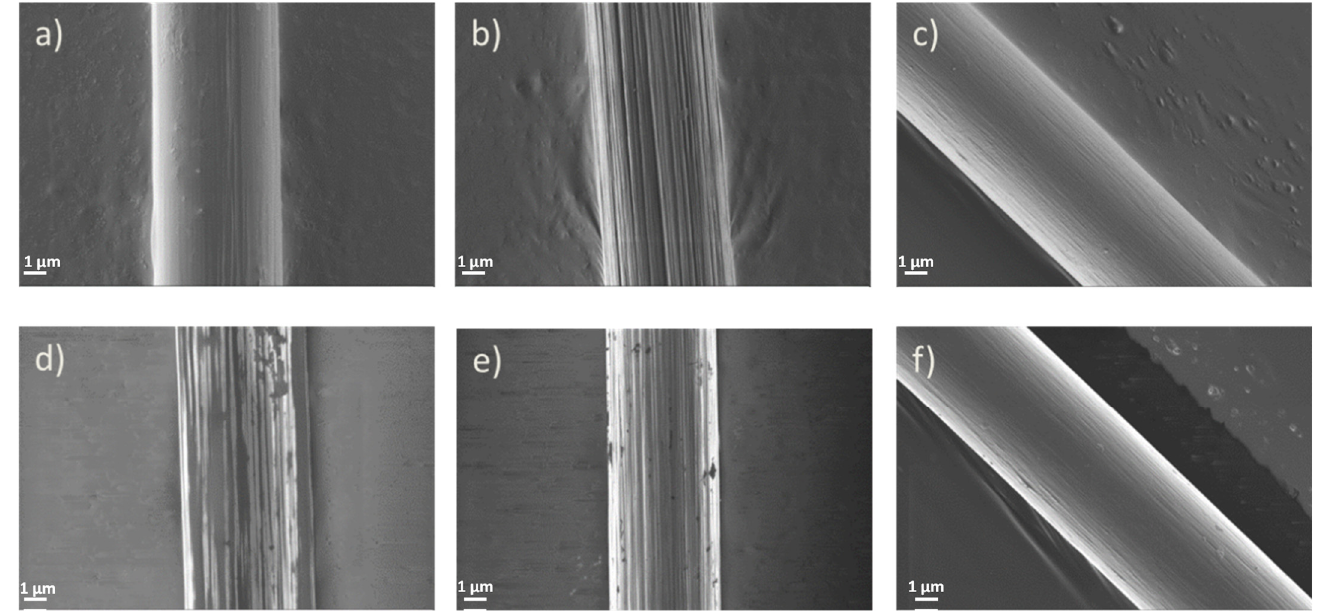
Figure 6. SEM Images of sized ( a , d ), non-sized ( b , e ), non-treated ( c , f ) carbon fibers.